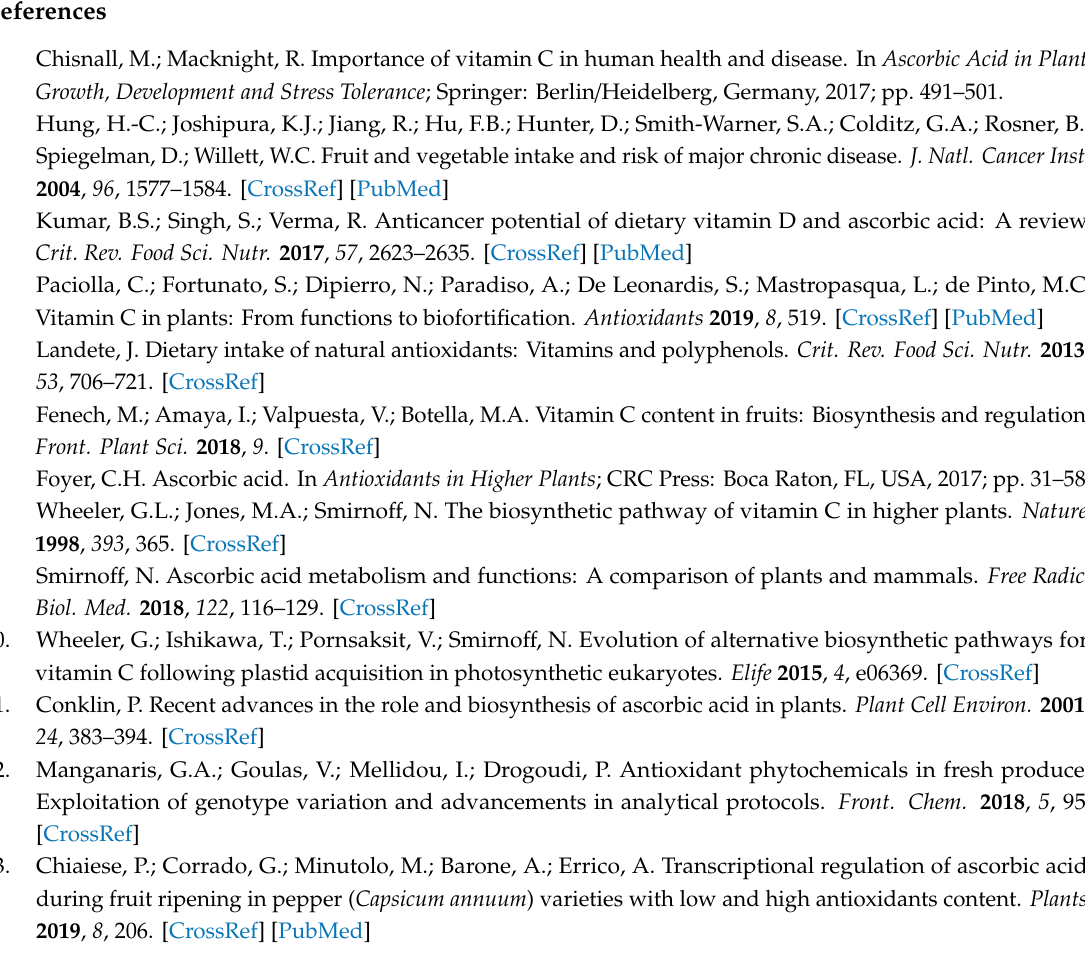
Table S1: List of the primers used in this study. Primers sequences are in 5 (cid:48) to 3 (cid:48)